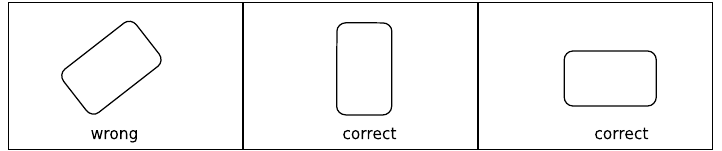
Figure 4.5: The node orientation must be horizontally or